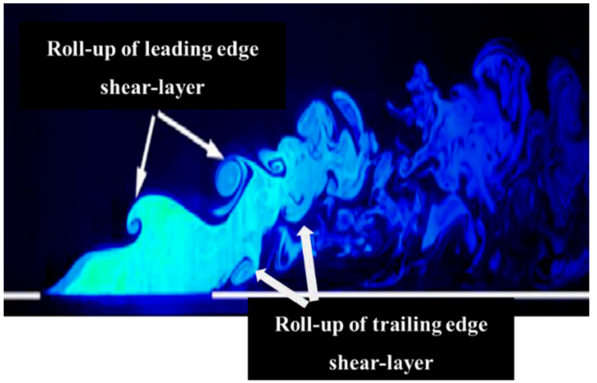
Figure 10. Two independent vortices in the jet shear-layer structure obtained from a laser-induced fluorescence (LIF) visualization [22].